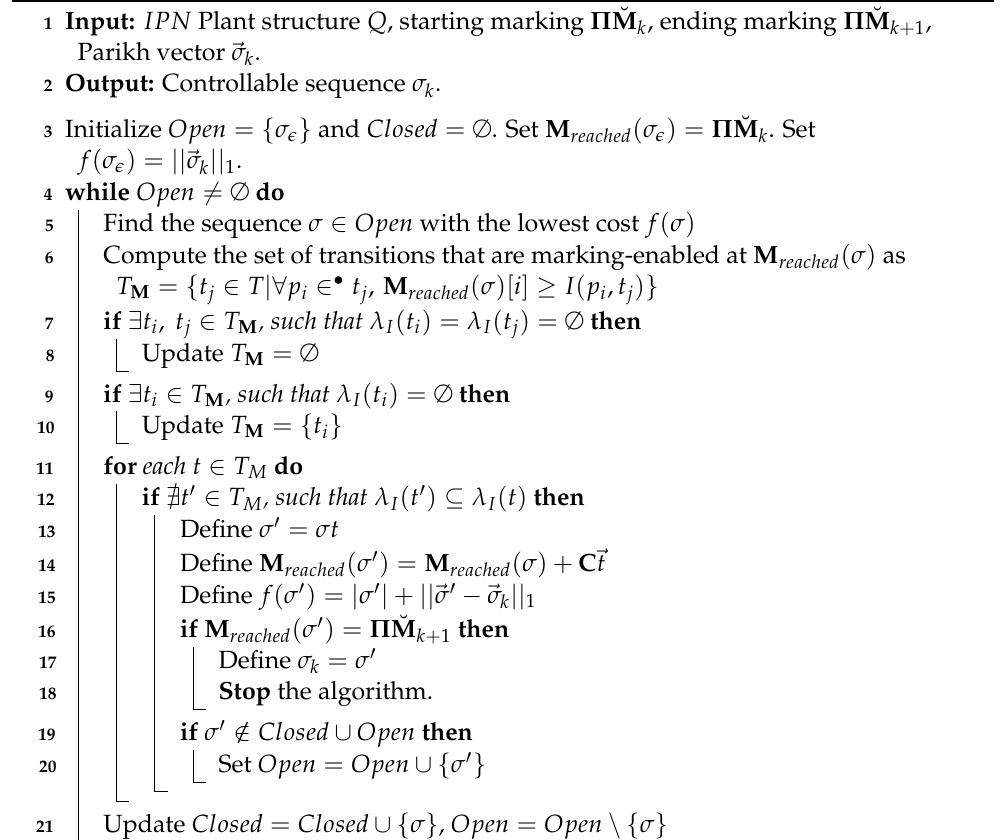
Algorithm 1: Computation of a controllable sequence σ k